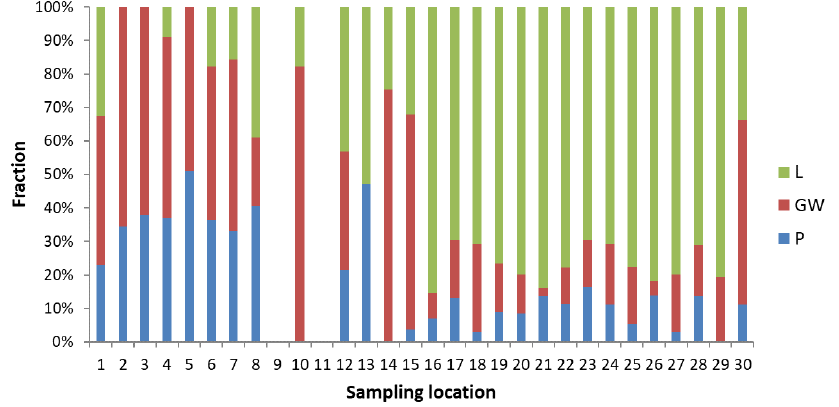
 18 O. Samples 9 and 11 were not included. Based on data from February 2016. using both EC and δ 18 O. Samples 9 and 11 were not included. Based on data from February 2016.